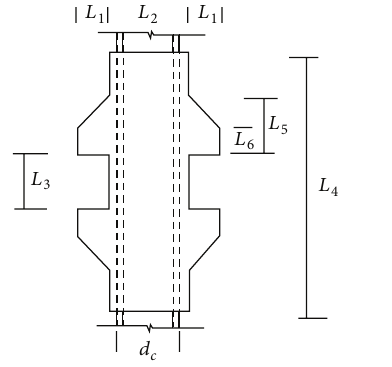
Figure 5: Connection plate dimensions.